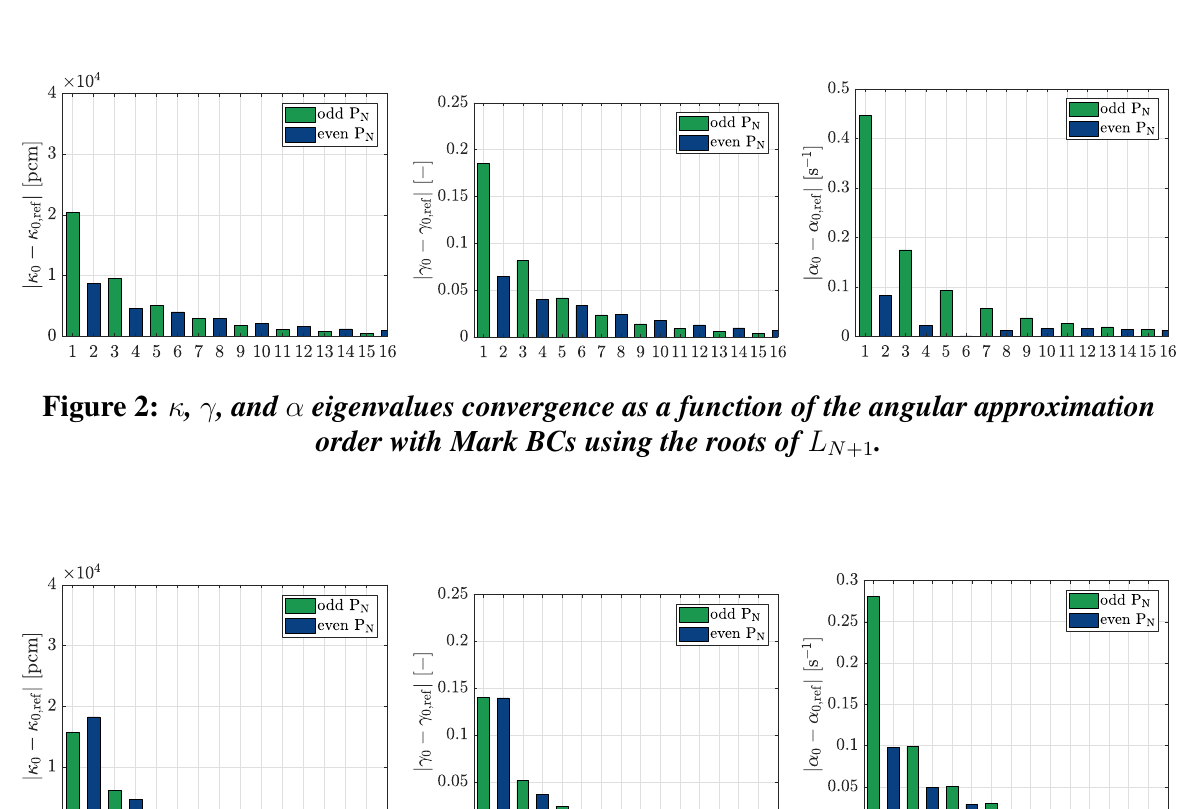
Figure 3: κ , γ , and α eigenvalues convergence as a function of the angular approximation order with Marshak